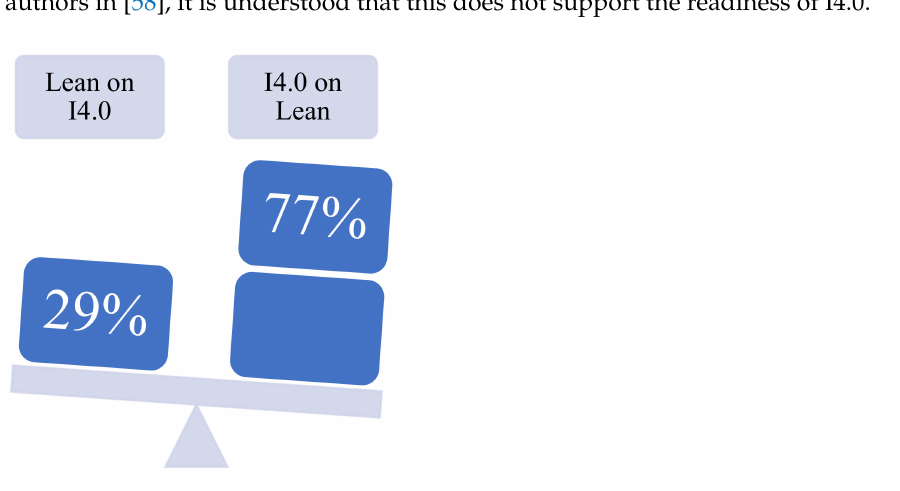
Figure 7. Proportion of influence of the lean concept on I4.0 ( left ) and I4.0 on lean ( right